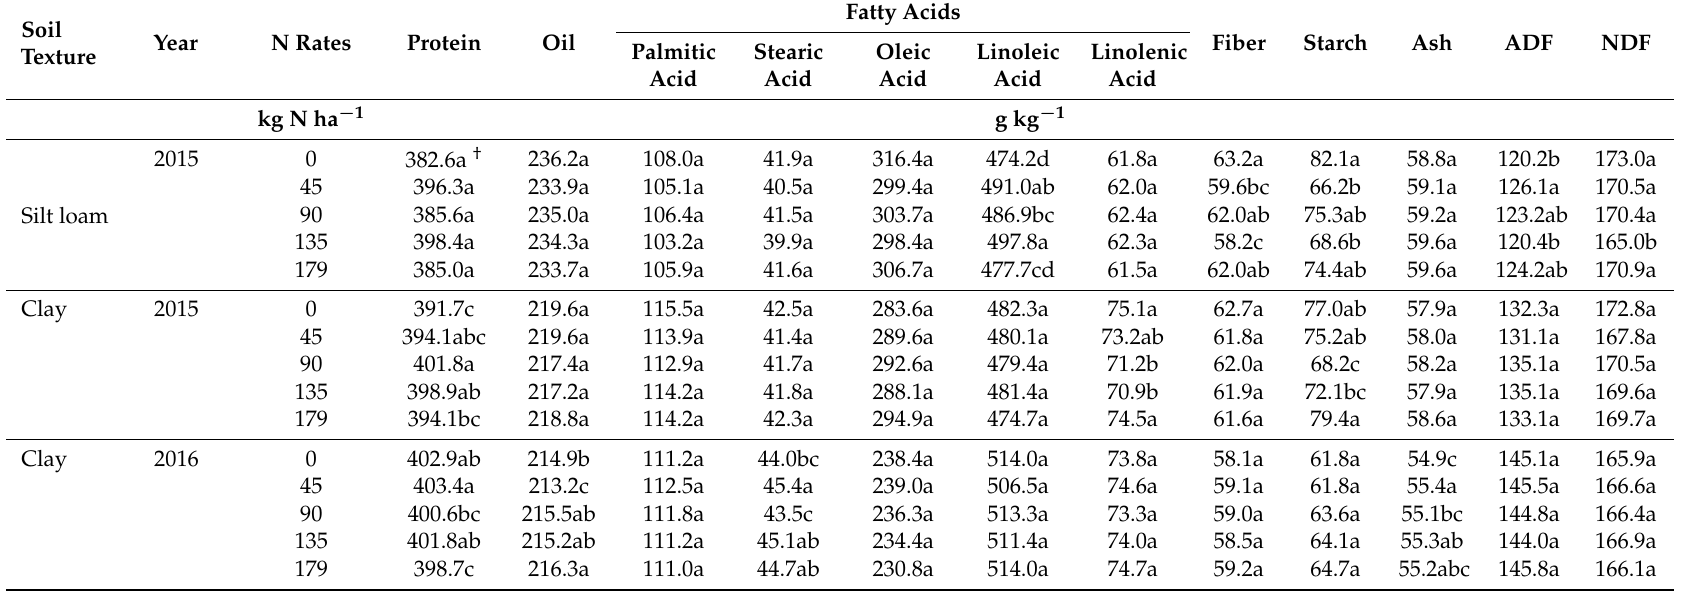
Table 2. Soybean seed protein, oil, fatty acids, starch, fiber, and ash as affected by the N application rates in 2015 and